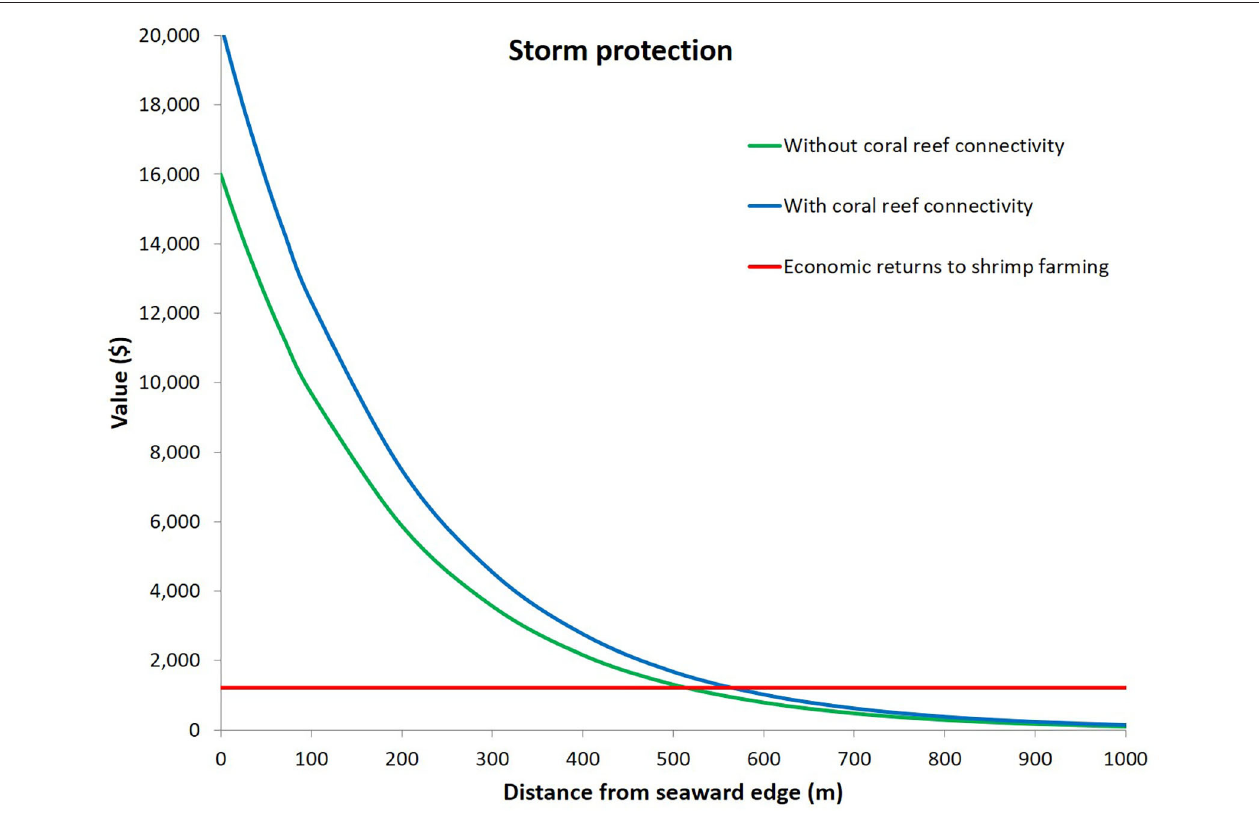
FIGURE 2 | Storm protection service and seascape connectivity between mangroves and coral reefs. The net benefits of storm protection of mangroves, with and without support from a near-shore coral reef, are compared to the economic returns of converting the mangrove landscape to shrimp aquaculture (red line). Without taking into account coral reef connectivity (green line), only the first 515 meters (m) of mangroves from the seaward edge should be conserved. However, if reef connectivity is included (blue line), then conservation of mangroves should extend further to 563m inland. Based on Barbier and Lee